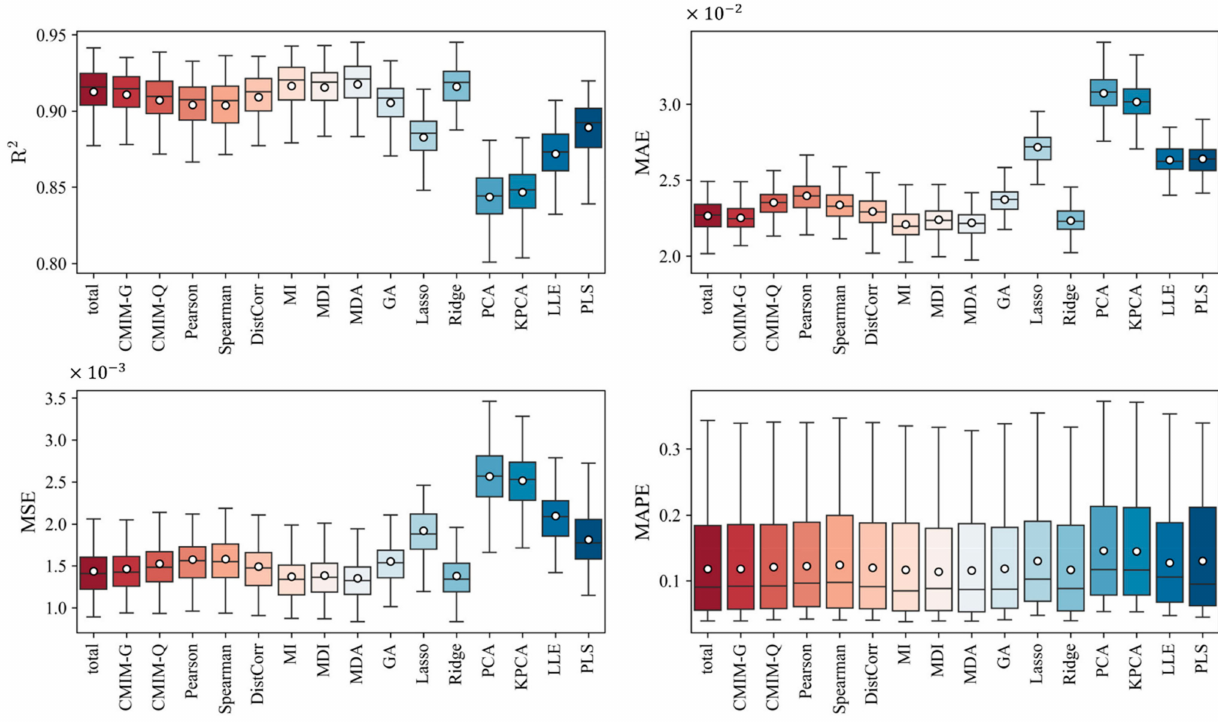
Figure 10. Comparison of metrics obtained by different methods with RF on Y DG